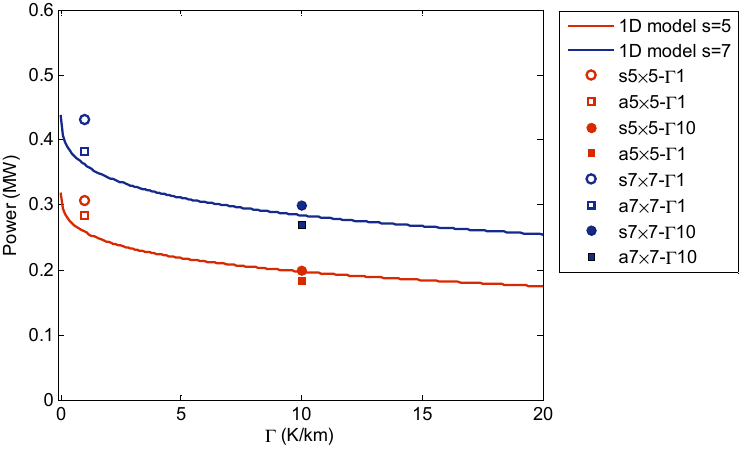
Figure 12. Effect of free-atmosphere stability on the power extracted by the turbines.